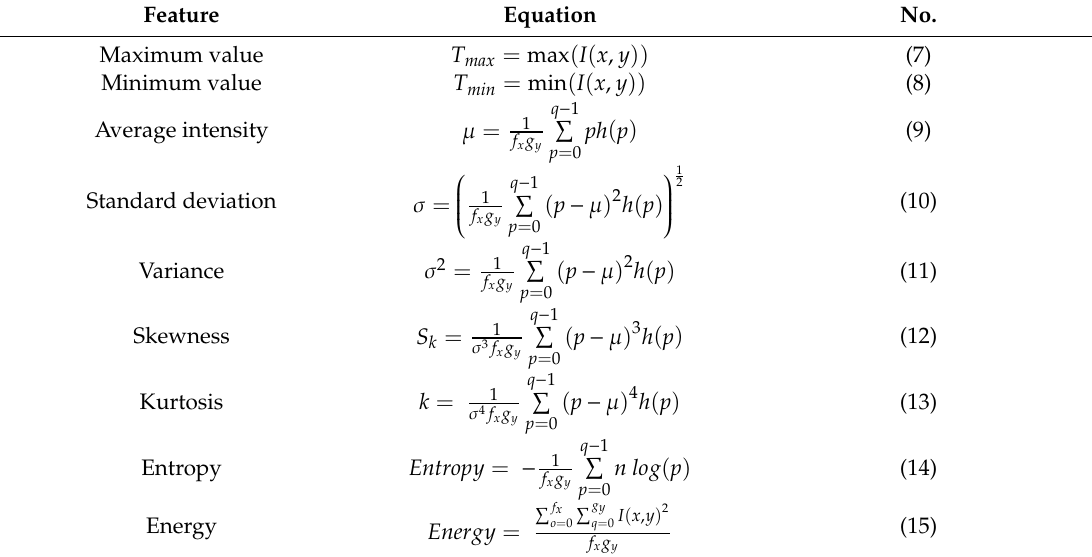
Table 2. Extraction of statistical features from the thermography